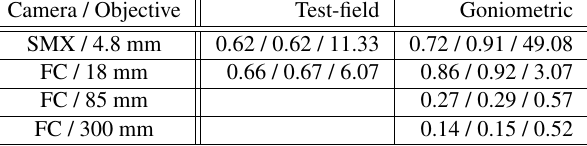
Table 2: RMS of image coordinate residuals from calibration in pixel. Full / reduced / no distortion correction.